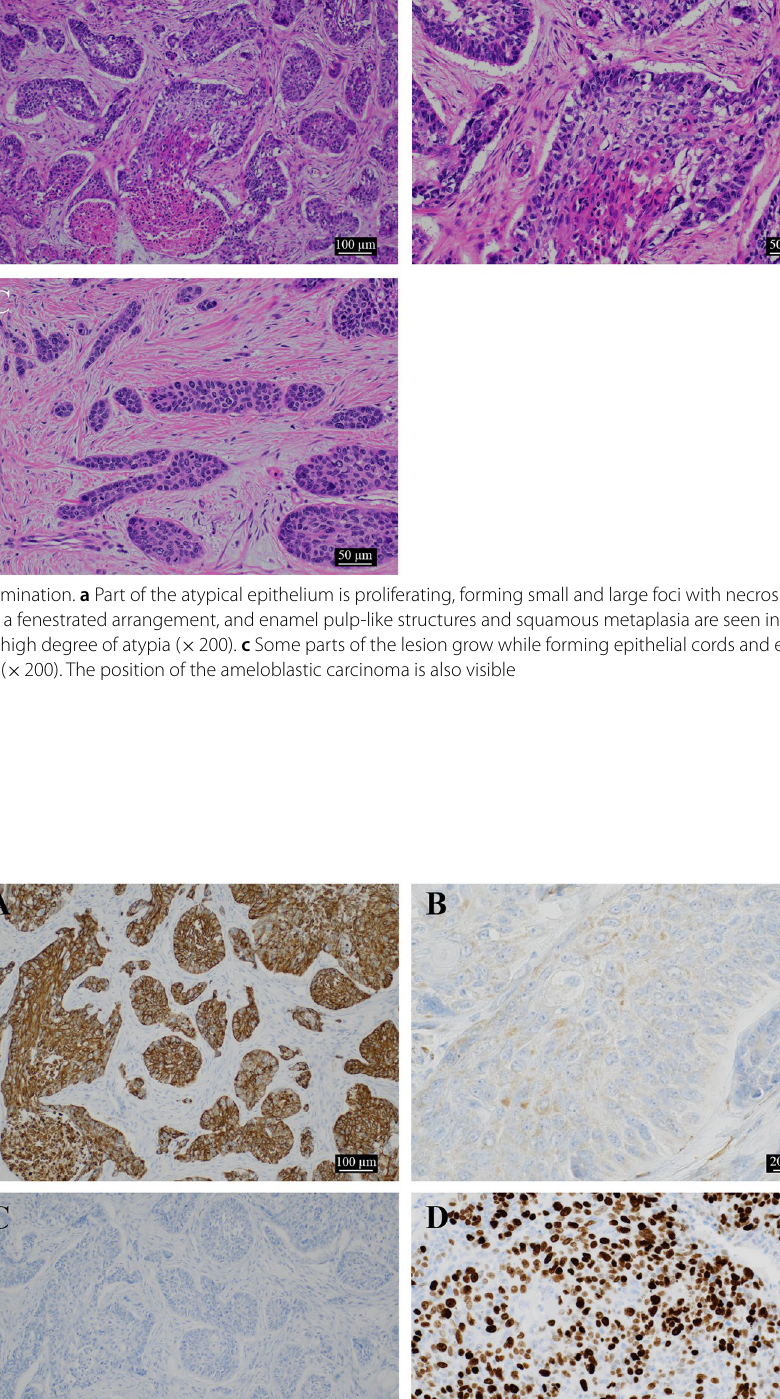
100). b α-SMA is partially weakly positive ( × 200). The position of the ameloblastic carcinoma is ×